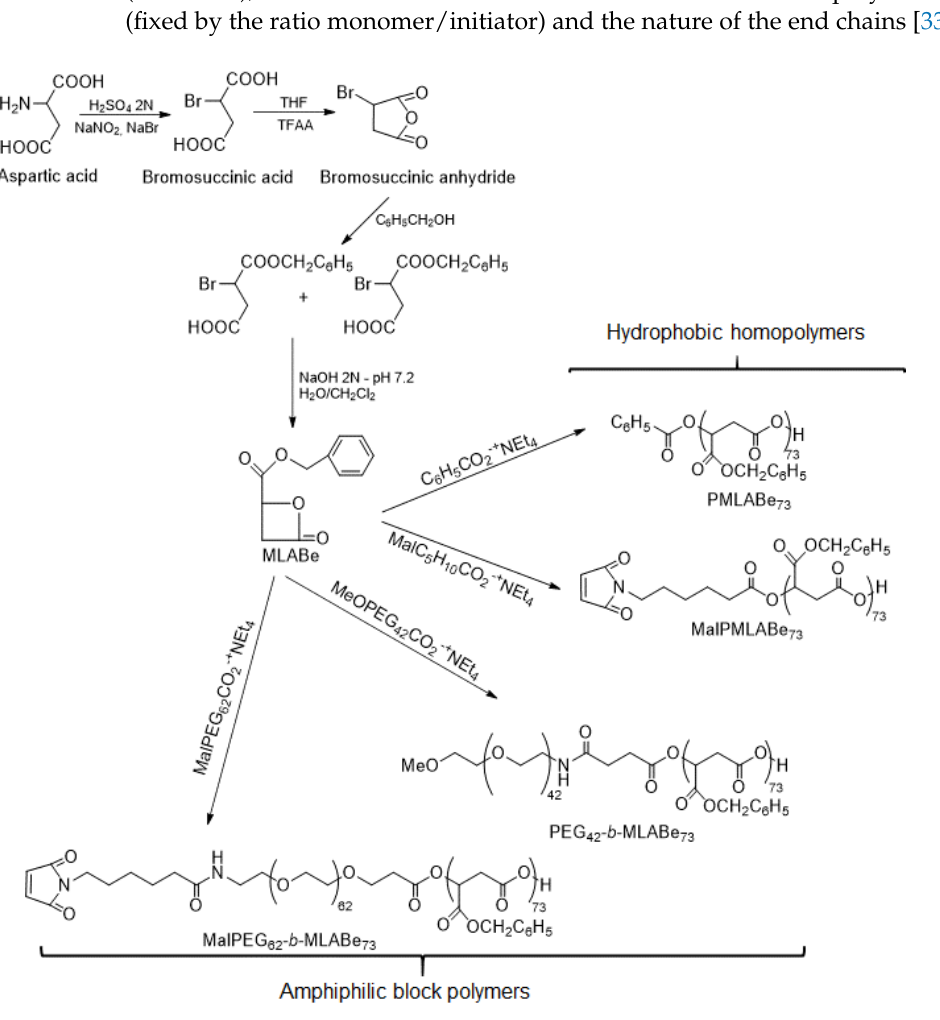
Figure 2. Structure of poly(malic acid)